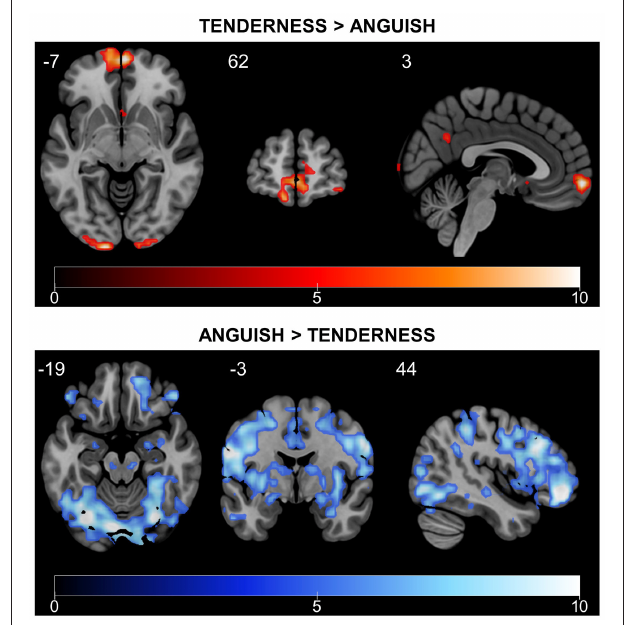
FIGURE 5 | Violin plots showing changes in the color of the virtual environment BCI during rtfMRI-NFB. Results from the rtfMRI-NFB runs are shown for the tenderness condition (orange plots) and anguish condition (purple plots) by the rtfMRI-NFB methods which include SVM = support vector machine and ROI = region of interest. The width of the violin plots changes according to the concentration of the results for specific levels of color change. Mean values are illustrated in red dots, and median values in white dots.